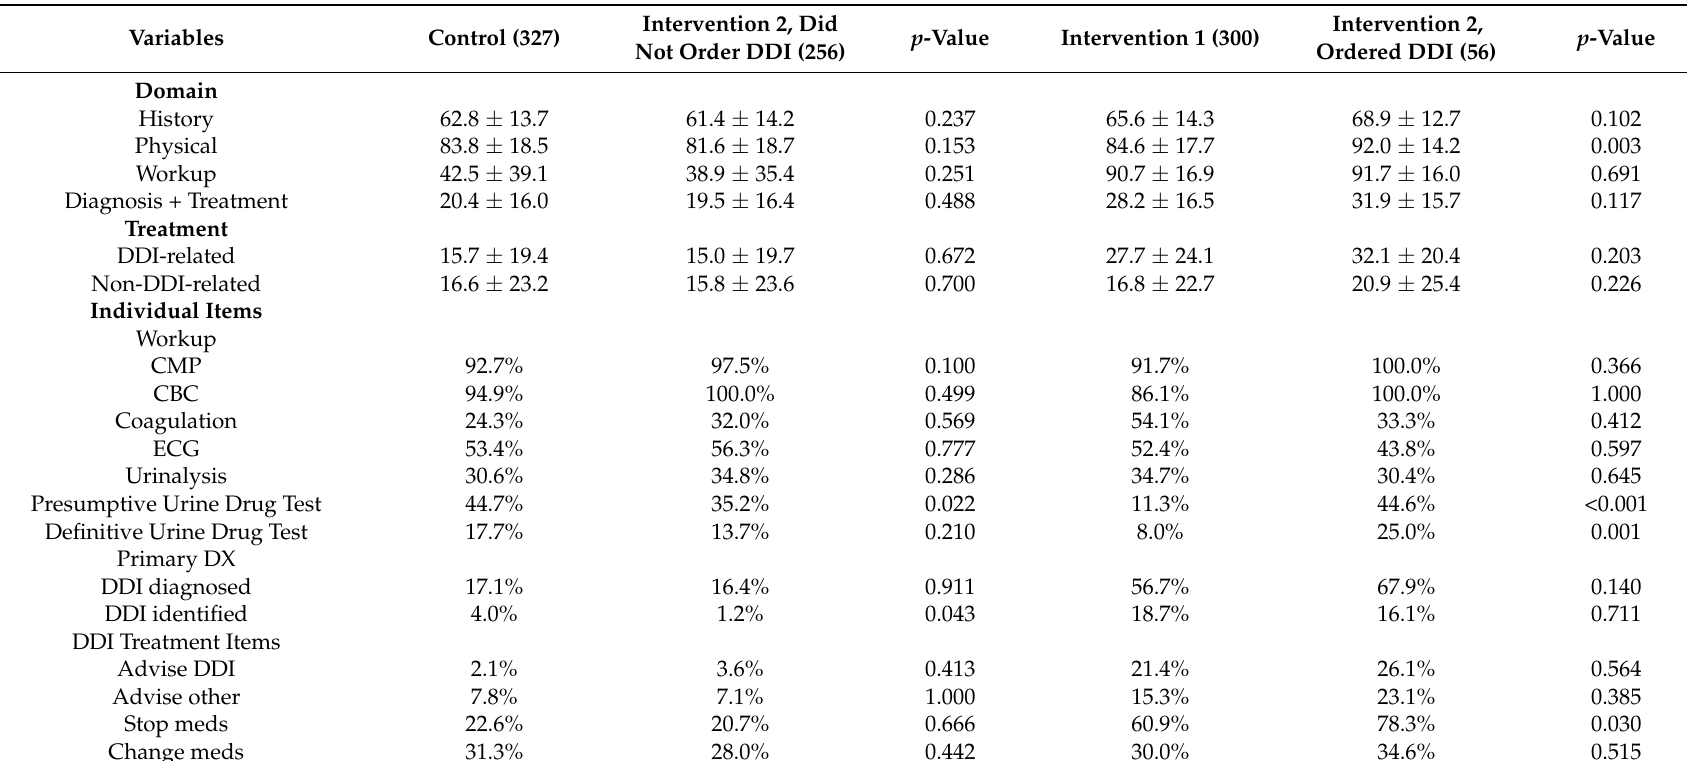
Table 8. Round 2 Comparison Results of: (a) Intervention 2 non-DDI test orderers vs. Controls and (b) Intervention 2 DDI test orderers vs. Intervention